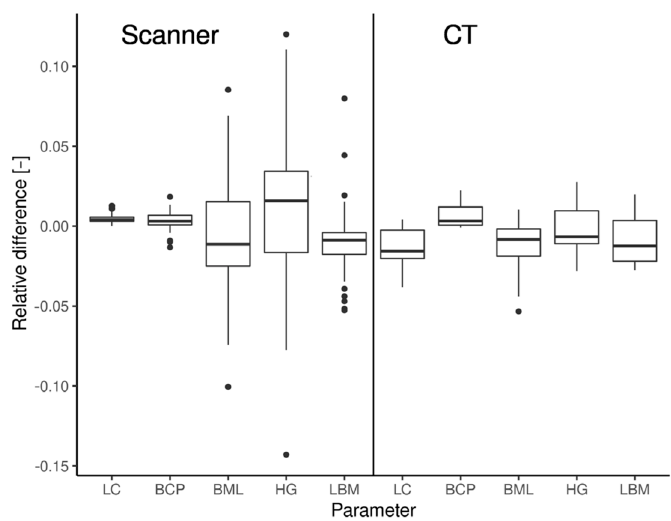
Figure 6. Box plot of relative deviations of measured parameters (X) by selected methods (see text in upper part). The deviances were standardized by hand measurement using the caliper.